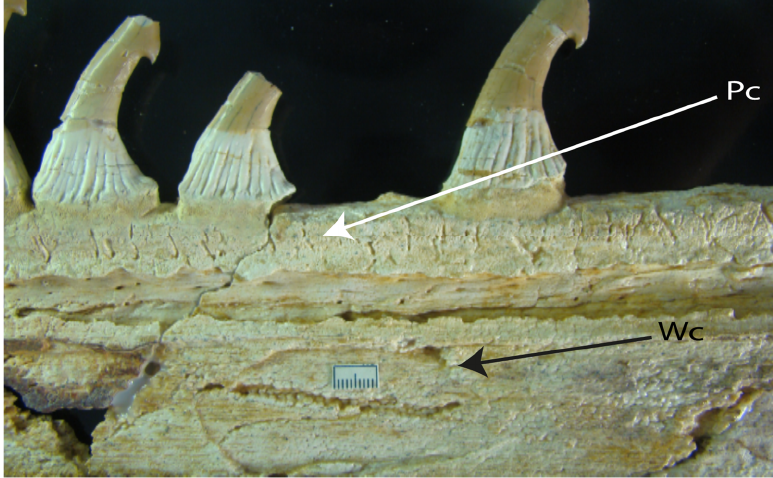
Figure 7. State (1): Rostrum section of: † Onchopristis numidus IPUW 353500. Abbreviations : Pc, peripheral cartilage; Wc, wood-like cartilage.